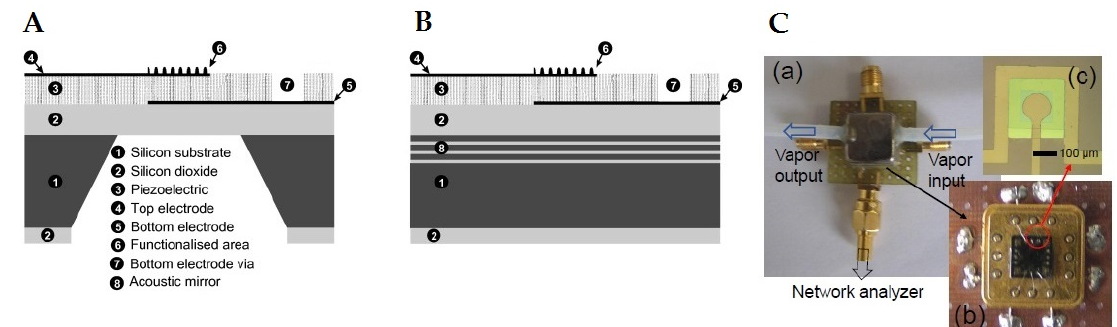
Figure 3. ( A ) Schematic design of a typical film bulk acoustic wave resonator (FBAR), ( B ) Schematic diagram of solidly mounted resonator (SMR), adapted with permission from [90]. ( C ) ( a ) Image of packaged FBAR sensor designed for sensing of formaldehyde, ( b ) FBAR device integrated with PCB, ( c ) magnified image of sensor element, adapted with permission from [109].